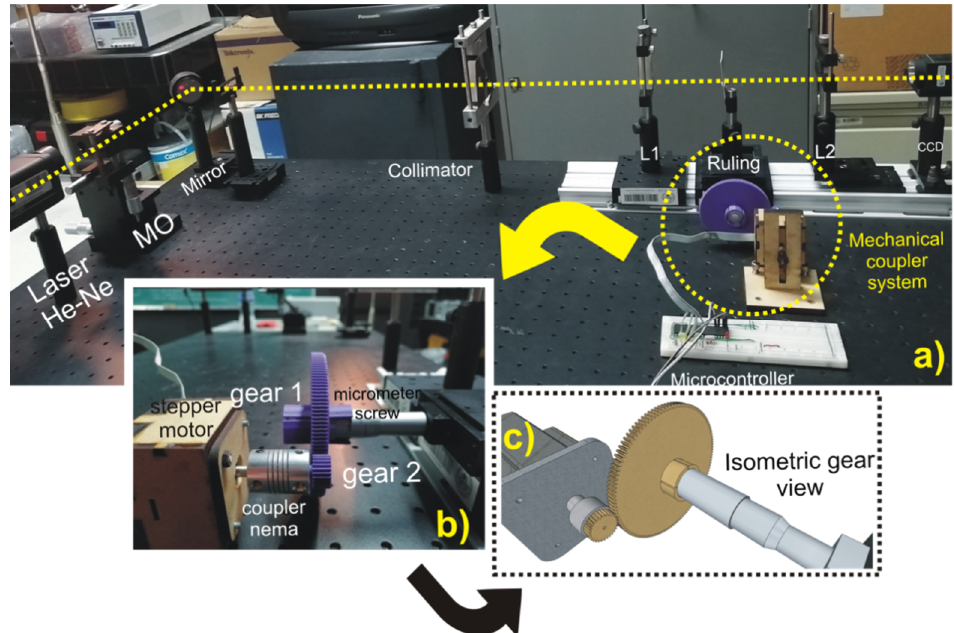
Figure 3. An automated DACPI system: ( a ) implementation of the system, ( b ) detail of the gear transmission system, and ( c ) the designed spur gear transmission.